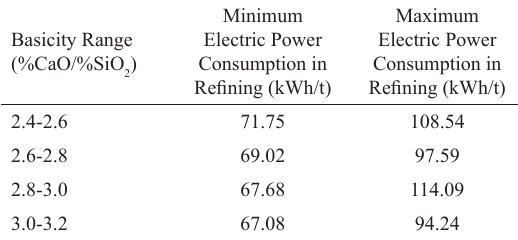
Table 3: Extremes values obtained from electric power consumption for the main basicity ranges.